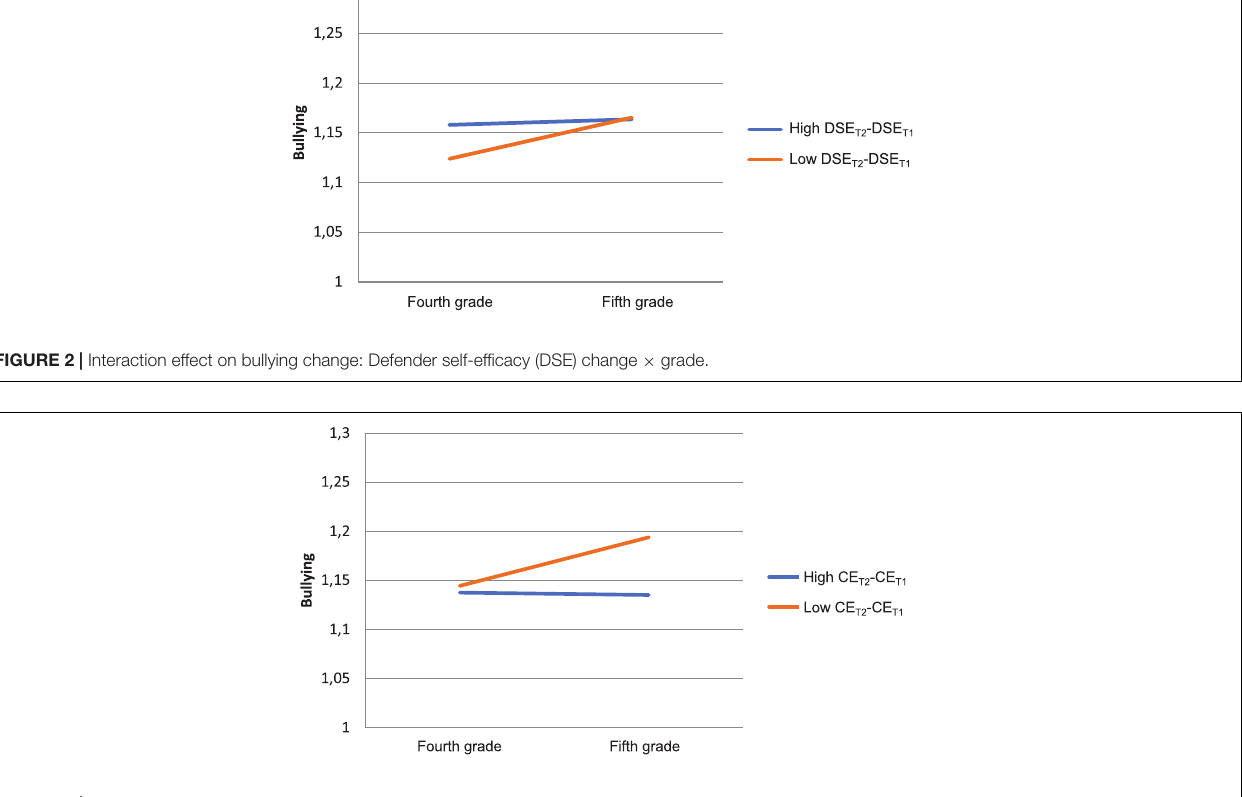
FIGURE 3 | Interaction effect on bullying change: Collective efficacy (ce) change ×